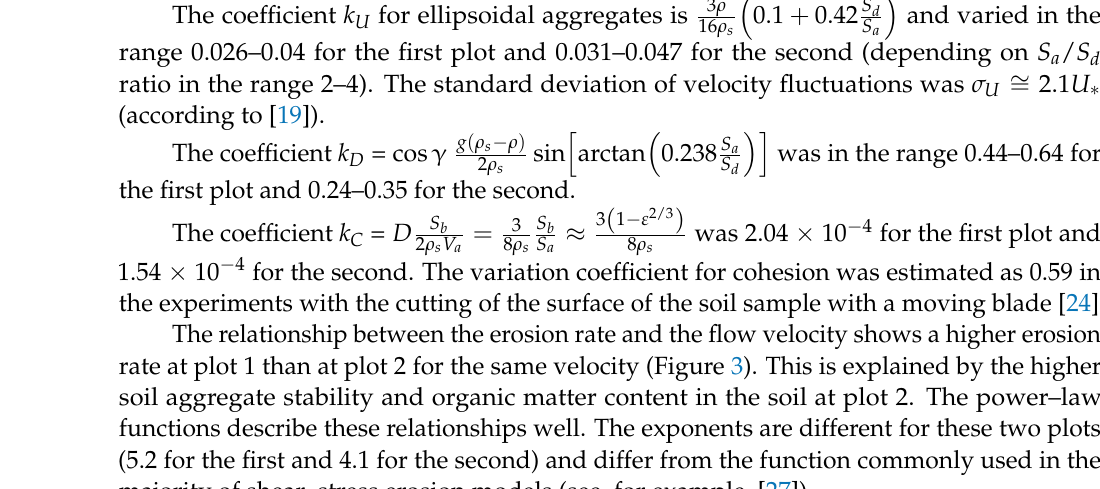
× 10 − 4 for the second. The variation coefficient for cohesion was estimated as 0.59 in the experiments with the cutting of the surface of the soil sample with a moving blade [24]. Table 1. The main characteristics of the experiments in Ballantrae Hill Country. N Q , l/s U , m/s W , m d , m U * Plot–Soil–Run